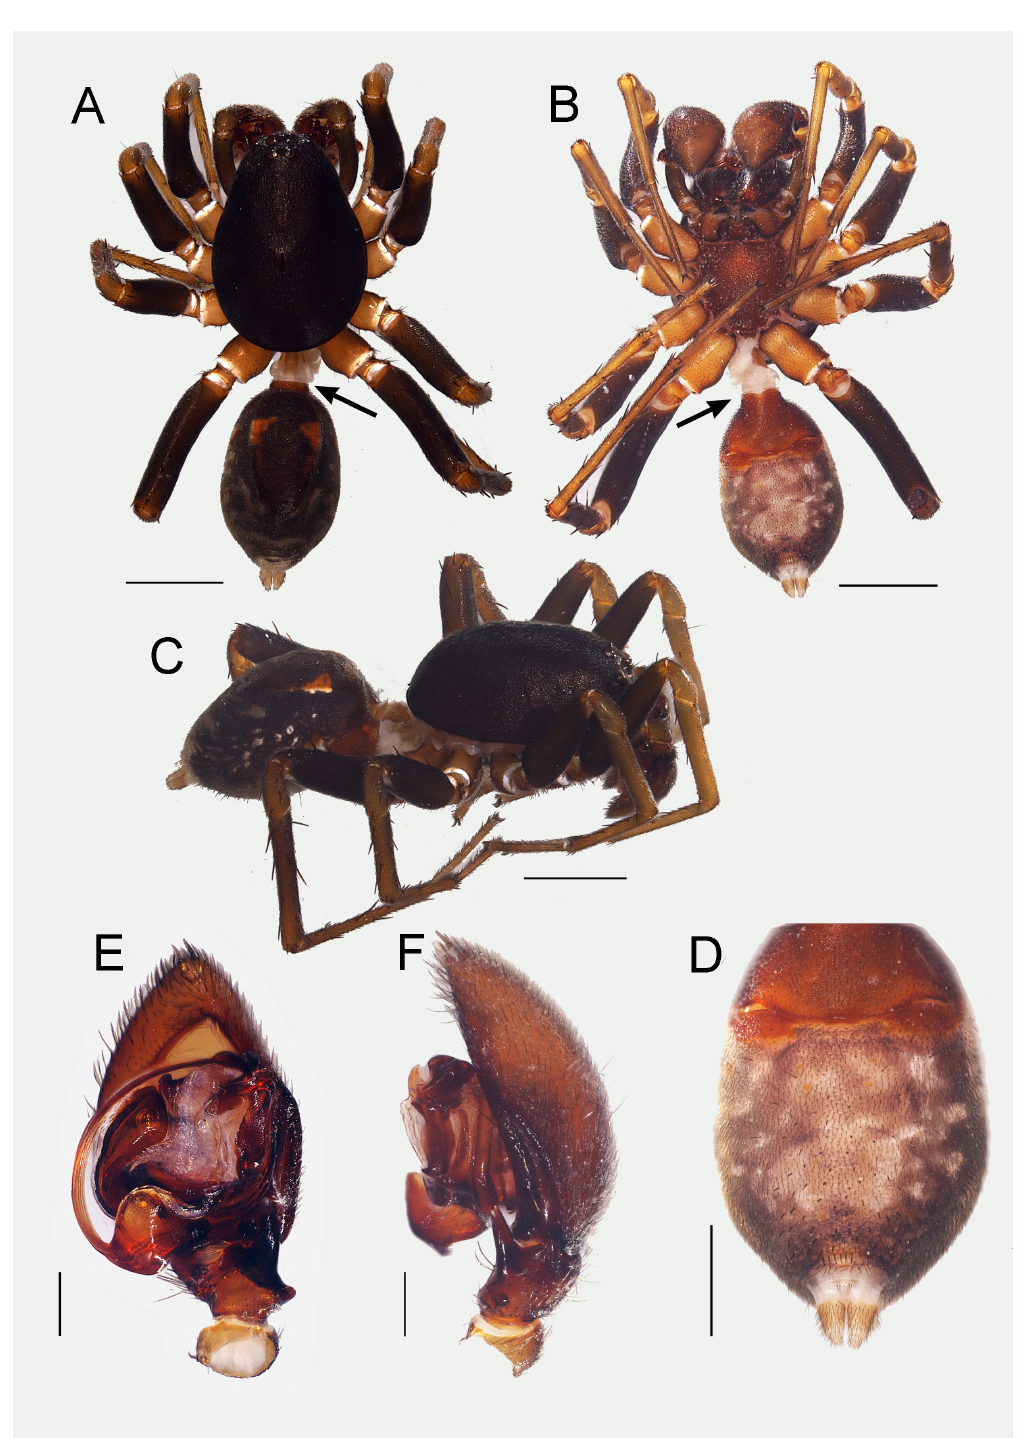
Fig. 8. Cambonilla symphonia Jocqué & Henrard gen. et sp. nov., male holotype A . Habitus, dorsal view. B . Habitus, ventral view. C . Habitus, lateral view. D . Abdomen, ventral view. E . Male palp, ventral view. F . Male palp, retrolateral view. Arrows indicate tubular extension. Scale bars: A–C = 2 mm; D = 1 mm; E–F = 0.5